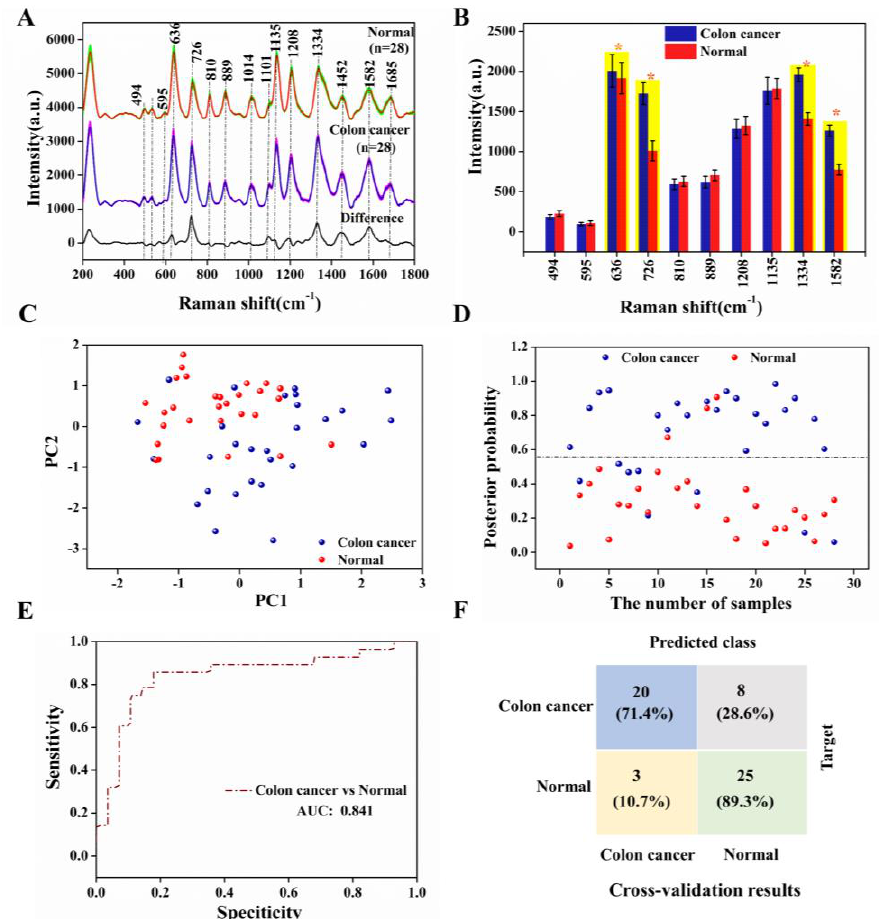
Figure 6. ( A ) Averaged SERS spectra of the colon cancer ( n = 28) and normal ( n = 28) serum samples and the difference spectra, where the shaded areas represent the mean standard deviations; ( B ) The corresponding histograms of the average intensities and standard deviations of the SERS peaks of the colon cancer and normal groups; ( C ) Two-dimensional scatter plot using two PCs for the colon cancer and normal groups; ( D ) The discrimination scatter plot scores of the posterior probabilities using two PCs for the colon cancer and normal groups; ( E ) ROC classification results for the PCA-LDA analysis generated groups using the leave-one-out and cross-validation methods (AUC: integration areas under the ROC curves); ( F ) Confusion matrices of the colon cancer and normal groups prediction results using PCA-LDA analysis.